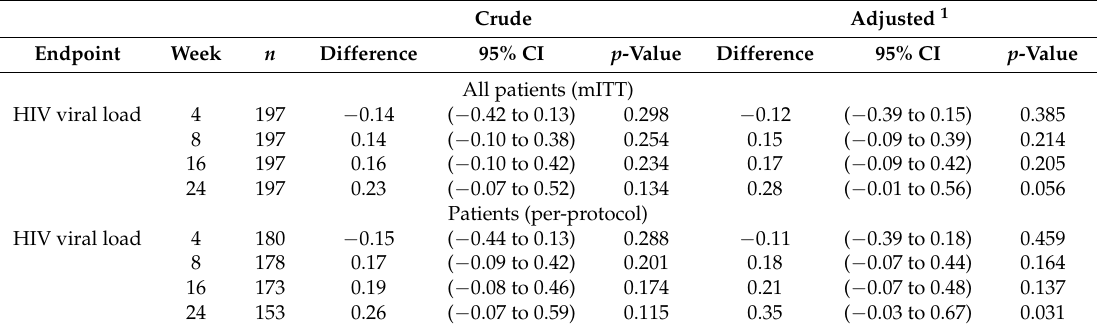
Figure 2. Primary efficacy analyses. HIV viral load was assessed at baseline and at weeks 4, 8, 16, and 24 after initiation of vitD 3 + PBA supplementation. The efficacy analysis included comparison of log HIV viral load in the vitD 3 + PBA and placebo treatment groups between week 0 and week 8. Crude data from the mITT cohort are presented as the mean and 95% CI. The solid line represents placebo while the dotted line represents vitD 3 + PBA treatment. Table 3. HIV viral load in placebo versus vitD 3 +PBA.